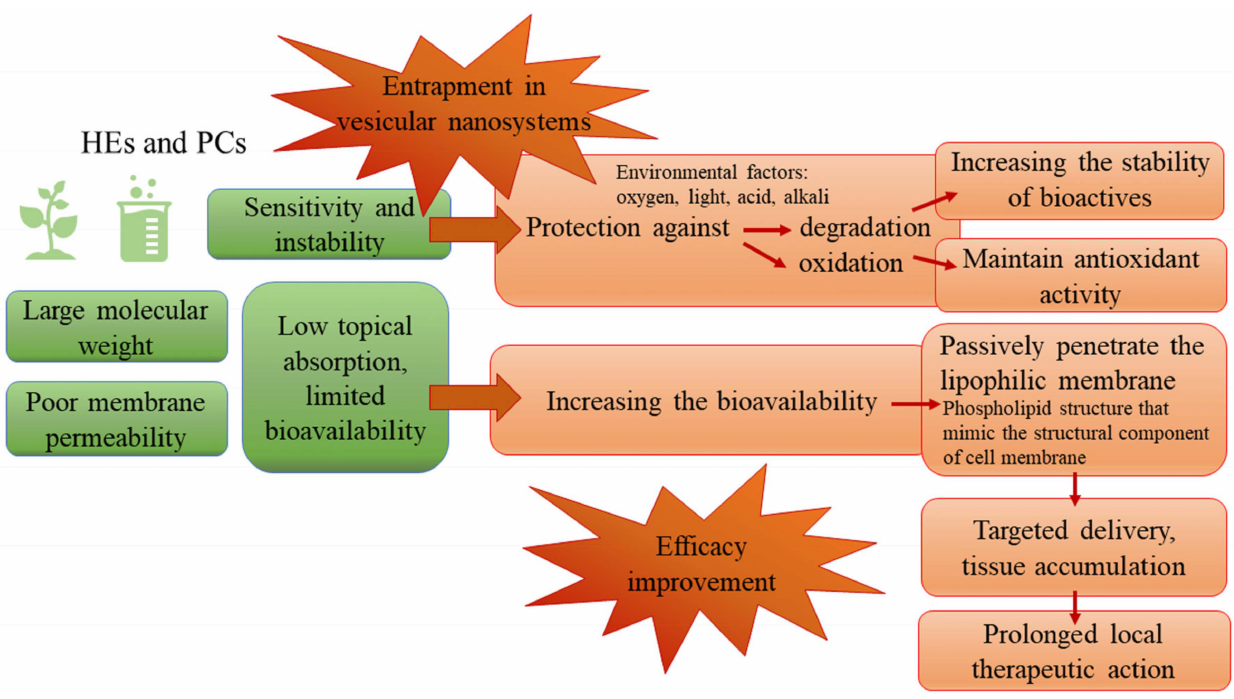
Figure 3. Advantages of herbal extracts’ entrapment into vesicular